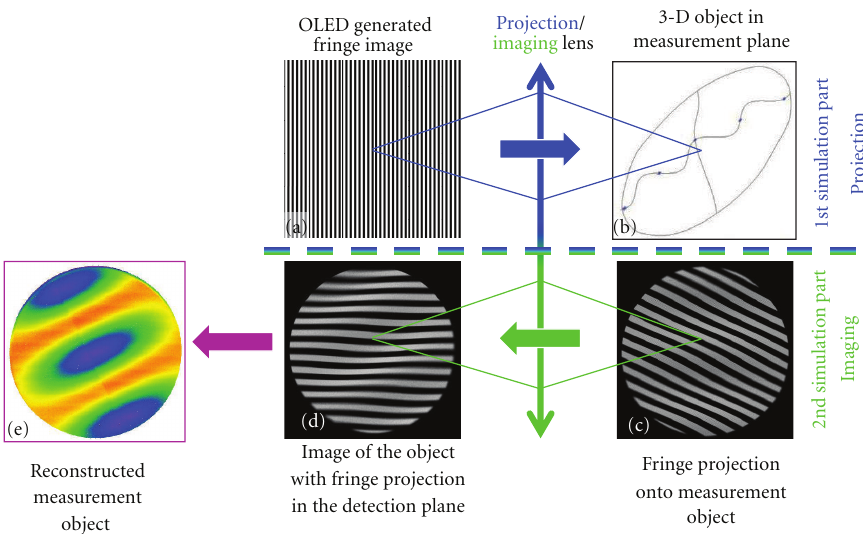
Figure 8: Principle of the 3D sensor system. The pattern images (OLED-BiMiD/(a)) are projected via a projection lens onto the measurement object (e.g., sinusoidal MO) (b). Then the detector (PD-BiMiD/(d)) detects the image of the measurement object during fringe projection (c). For this part the detected image of (c) is used as image/light source and is imaged into the BiMiD detector plane that is shown in (e). The 3D model is calculated with an internal Fraunhofer IOF software. (a) OLED generated fringe pattern image, (b) 3D measurement object, (c) fringe projection on the measurement object, (d) detected image of the measurement object during fringe projection, and (e) reconstructed 3D object.